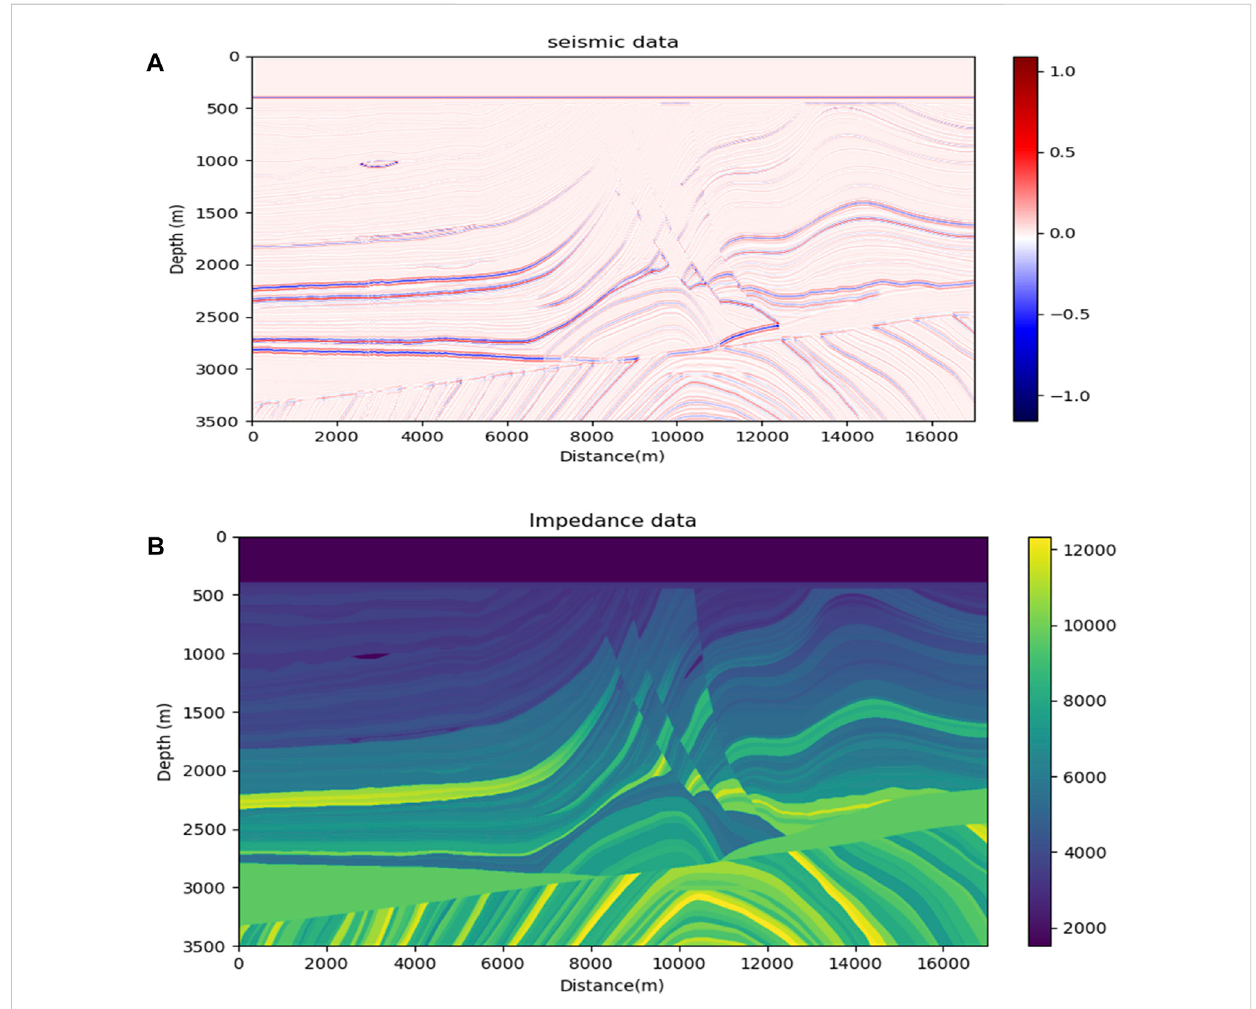
FIGURE 5 The Marmousi2 model. (A) Seismic data pro fi le; (B) real acoustic impedance pro fi